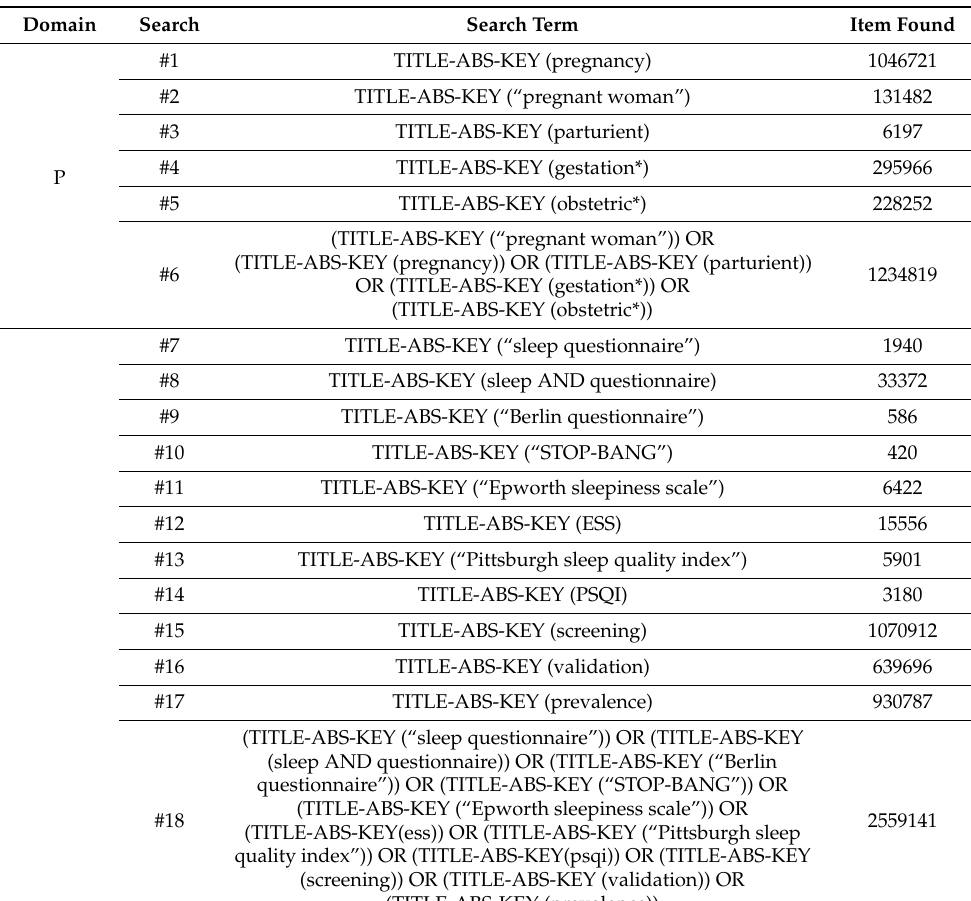
Table A2. Search terms are built from